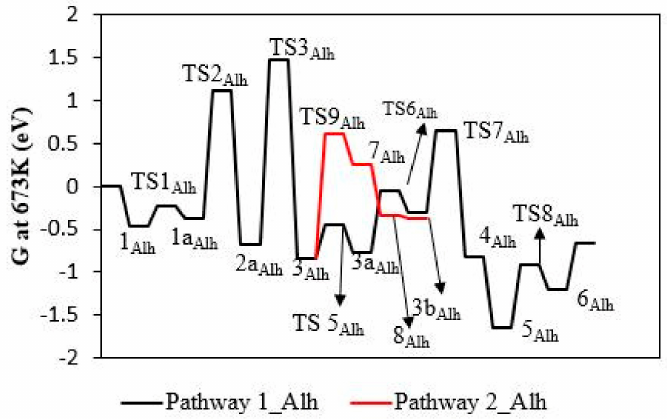
Figure 4. Free energy profile corresponding to Scheme 5 at 673.15